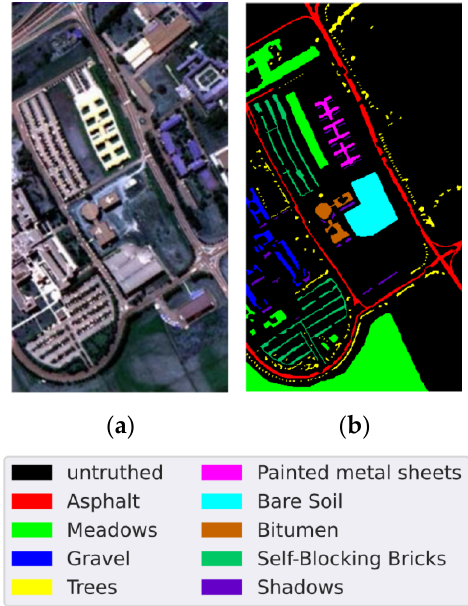
Figure 5. PU data set. ( a ) False-color image. ( b ) Ground-truth map. Table 2. Land cover classes and the numbers of samples in the PU data set.